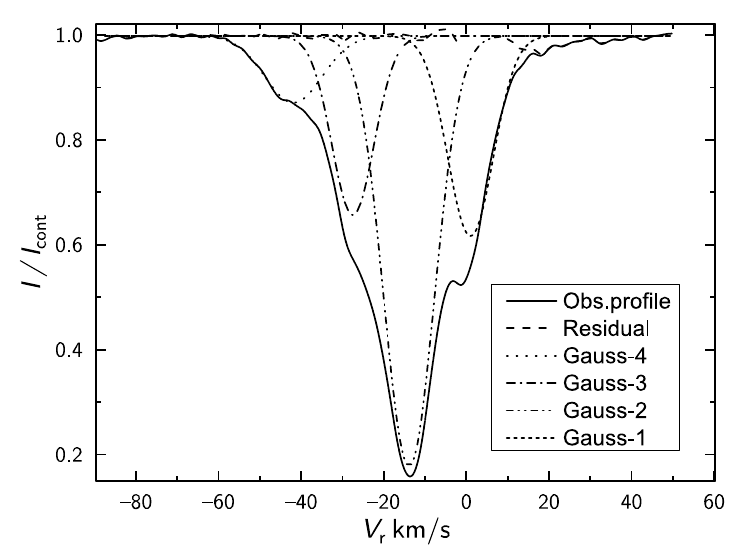
Fig. 2. The resolved interstellar blend of Ca II 3968 ˚A (solid curve) fitted with four Gaussian profiles vs. the heliocentric radial velocity V rhel . The top curve shows the